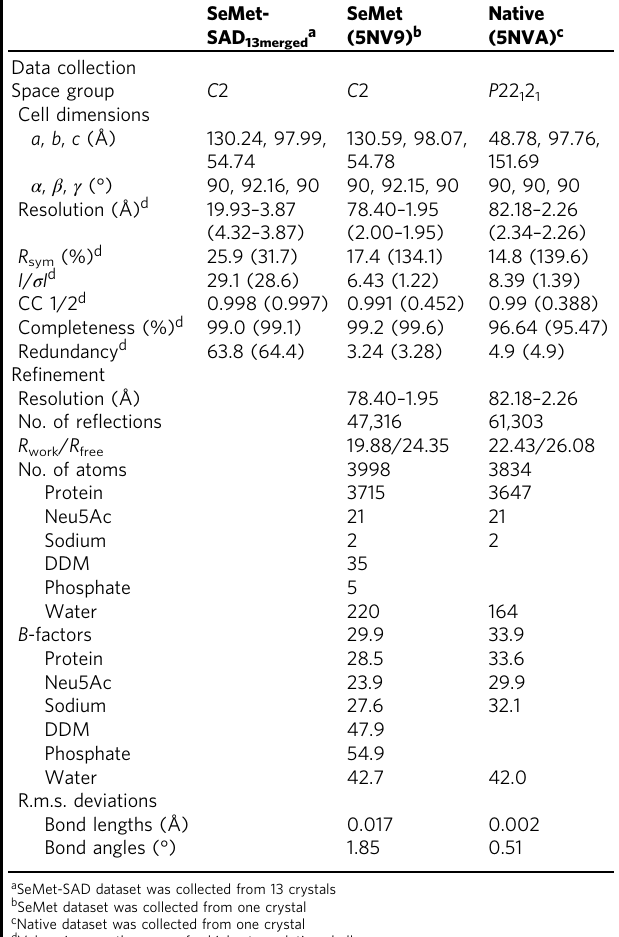
Table 1 Data collection and re fi nement